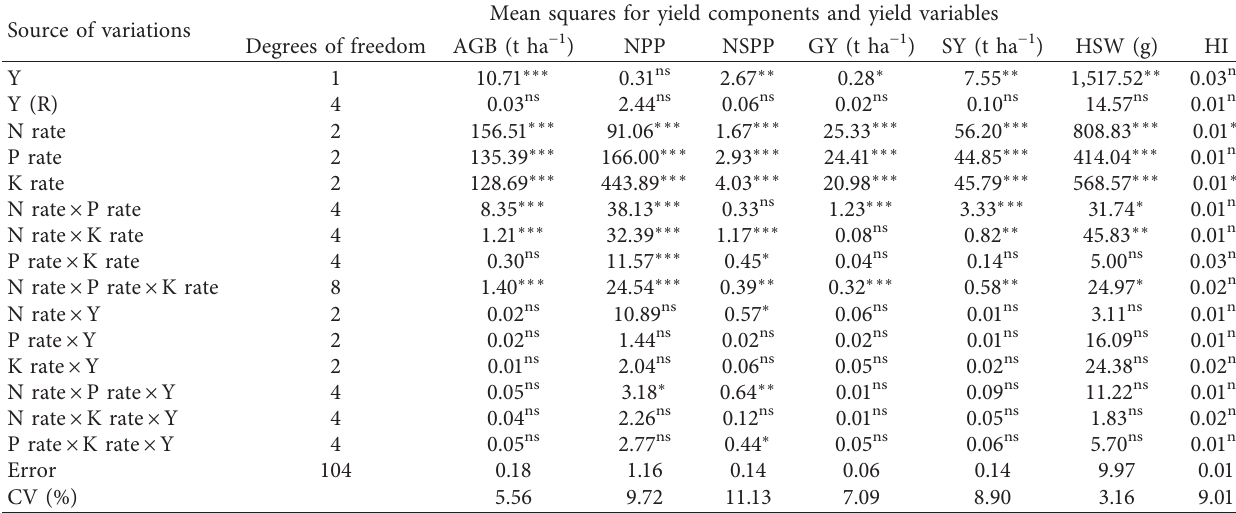
Table 5: Mean square values of the combined analysis of variance for the effects of year, mineral N, P, and K fertilizers application and their interactions on yield components and yield parameters of faba bean in Sodo Zuria District, southern